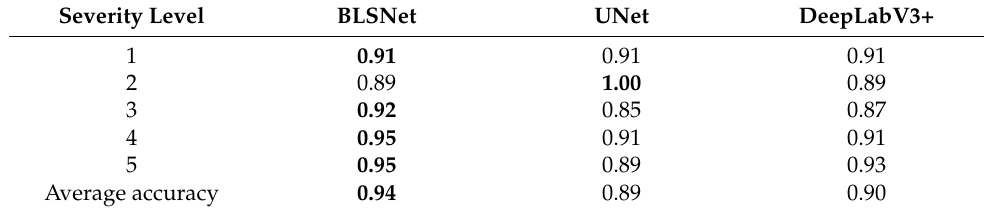
Figure 14. DeepLabV3+ confusion matrix. Table 5. Disease severity level estimation accuracy comparison.